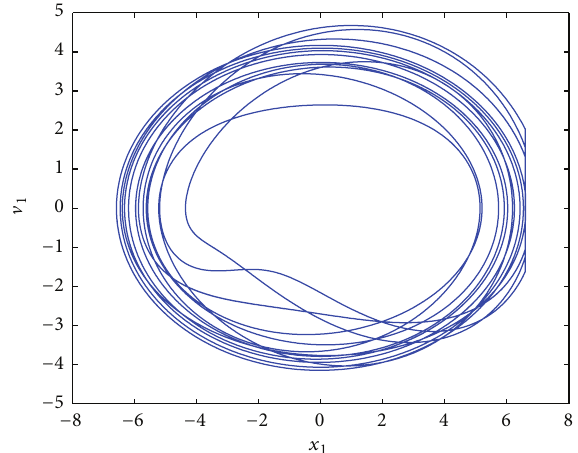
Figure 10: Phase portrait of the oscillator 𝑀 1 with 𝑏 = 6.6